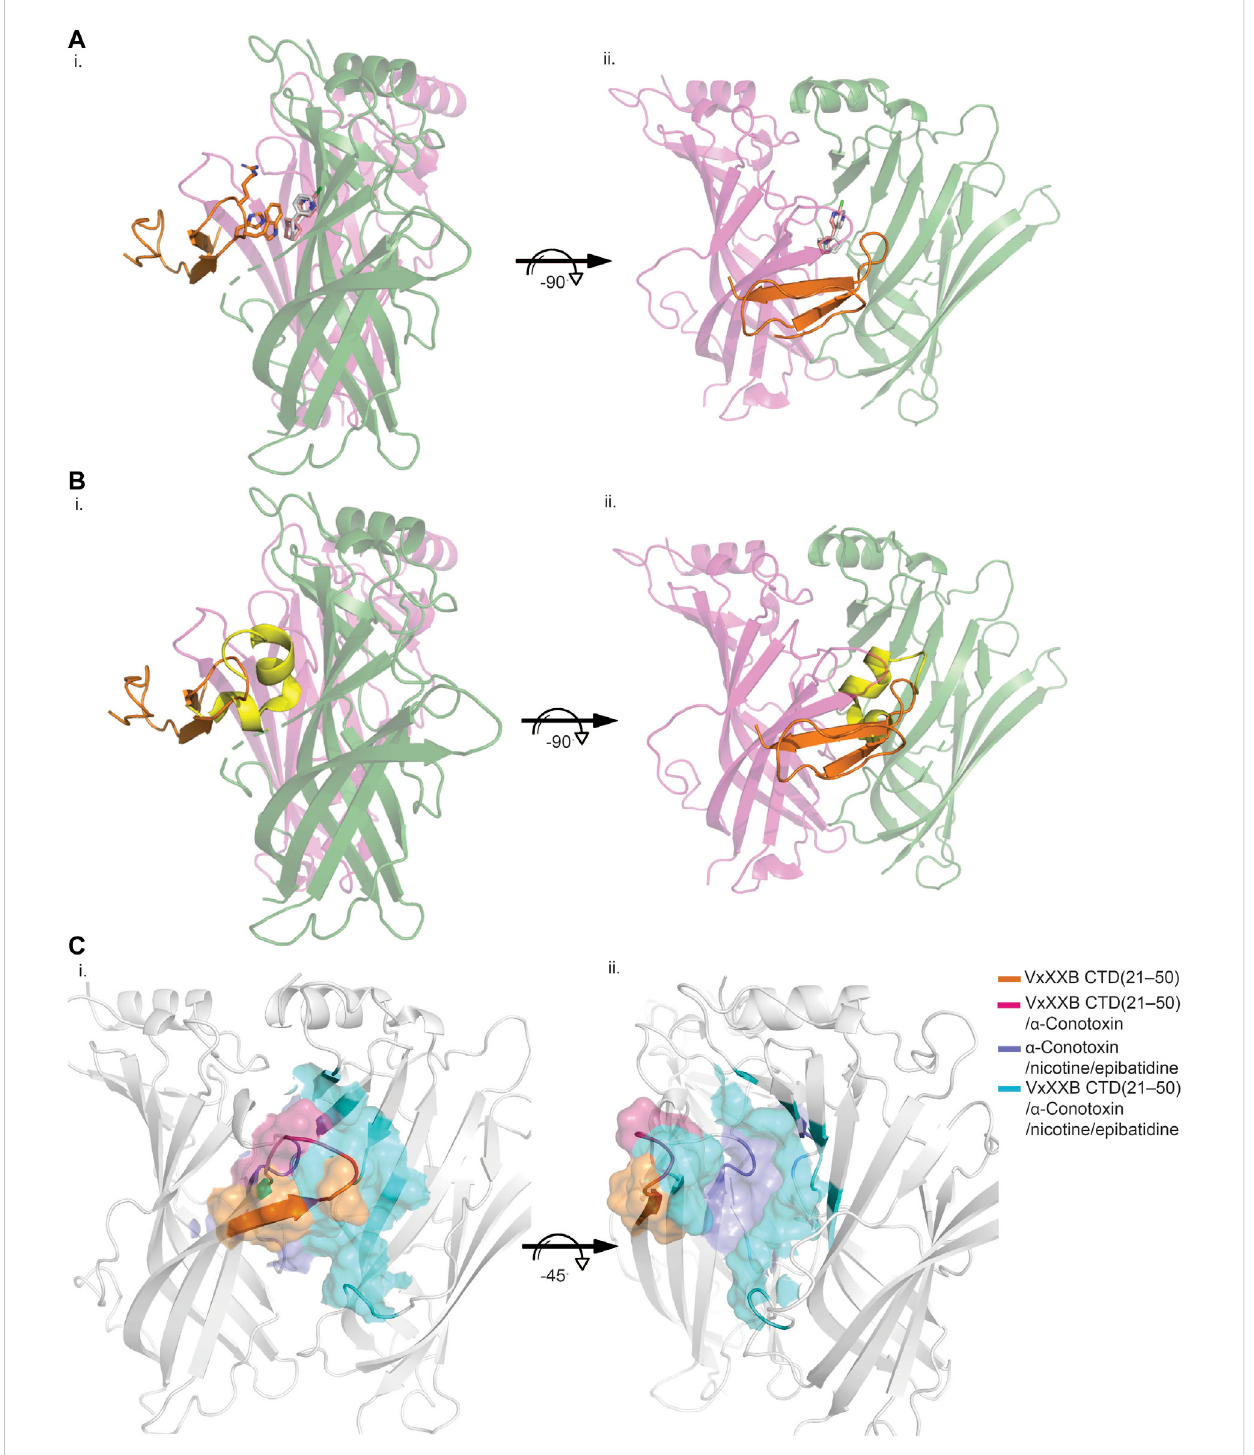
FIGURE 4 Allosteric binding site of VxXXB-C (21 – 50) at Ls -AChBP. The allosteric binding mode of VxXXB-C (21 – 50) is revealed through the lack of overlap in binding region with orthosteric agonist nicotine (grey stick) (PDB 1UW6)/epibatidine (pink stick) (PDB 2BYQ) (A) and competitive antagonist α -conotoxin LsIA(yellowcartoon) (B) viewedfromfront(i)andside(ii)viewasevidencedfromthepartialoverlapinthepairwiseinteractionsbetweenVxXXB-C(21 – 50) and orthosteric agonist nicotine. (C) Interacting regions of VxXXB-C (21 – 50), α -conotoxins, nicotine are shown with the unique interacting regions of VxXXB-C (21 – 50)